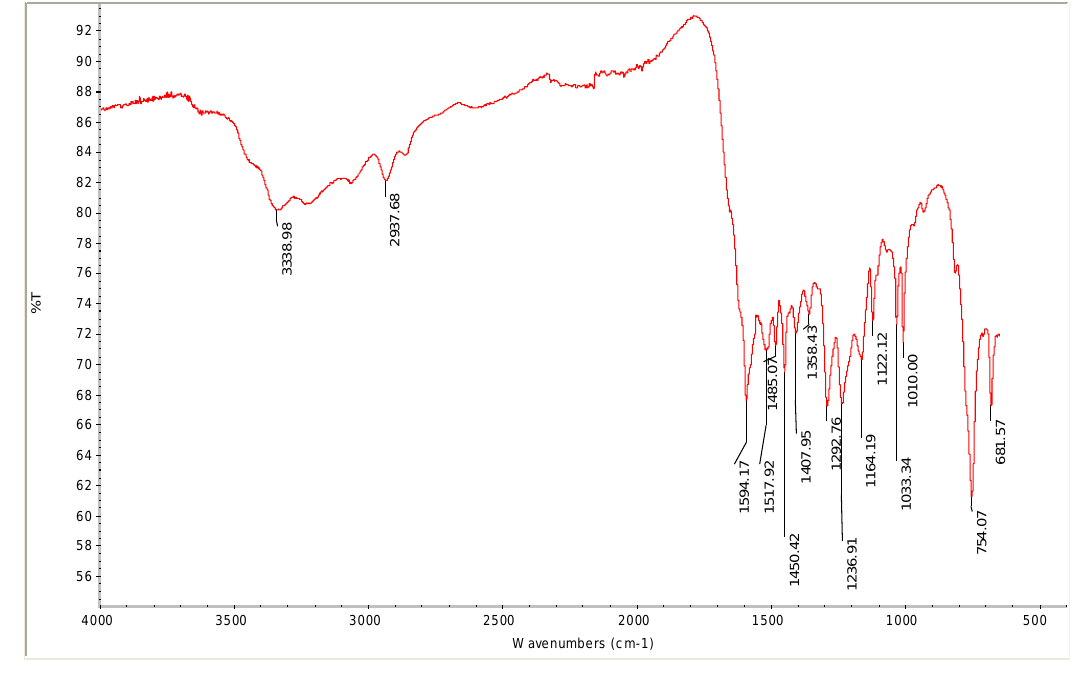
Figure S7: FT-IR spectrum of Schiff base polyether P o HOAND